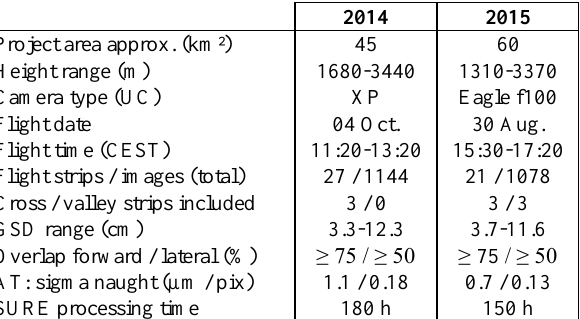
Table 2. Mission parameters and AT results for Oetztal and Pitztal.